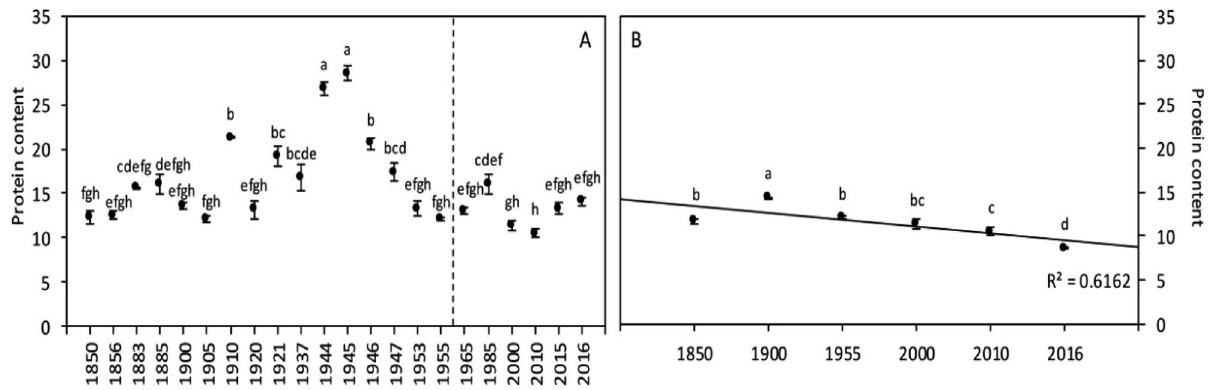
Figure 5. Wheat grain protein content of global ( A ) and Broadbalk experiment ( B ) samples. The dashed line corresponds to the separation between the [1850–1955] and [1965–2016] periods, based on the increase of [CO 2 ]. Data are mean ± standard errors (n = 3–14). The same letters indicate no statistically significant differences among years (Fisher’s LSD, p ≥